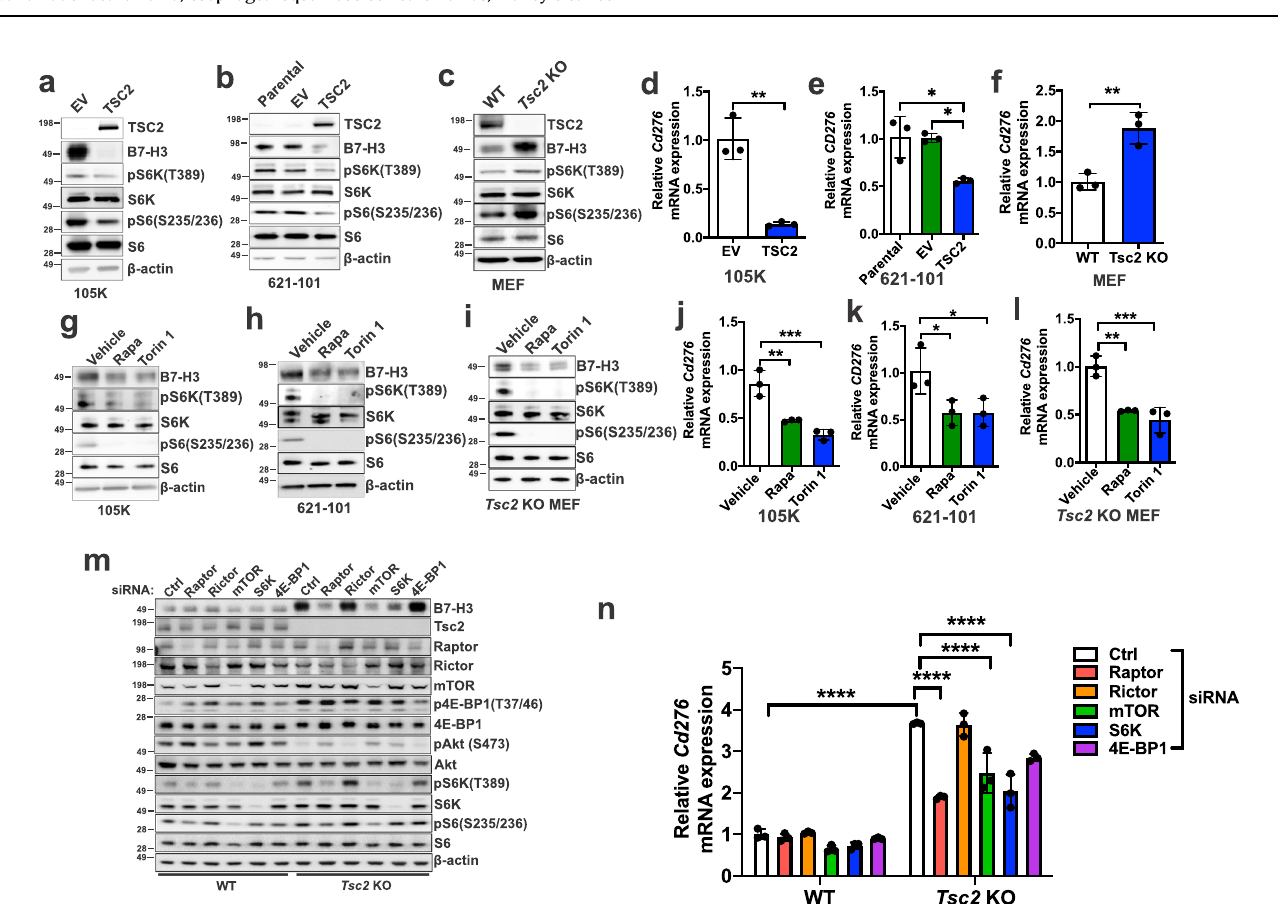
Fig. 1 | Elevated mTORC1 activity and B7-H3/ CD276 expression are associated with poorer clinical outcomes and immunosuppressive phenotypes. Kaplan- Meierplotofoverallpatientsurvivalstrati fi edbyhigh( n =2076)andlow( n =2185) CD276 expression ( a ), high ( n =2001) and low ( n =2268) mTORC1 score ( b ), and high CD276 expression plus high mTORC1 score ( n =1296) and low CD276 expres- sion plus low mTORC1 score ( n =1160) ( c ). Log-rank test. Forest plot of hazard ratios by tumor type and overall (with 95% con fi dence intervals) strati fi ed by high and low CD276 expression ( d ), high and low mTORC1 score ( e ), and high and low CD276 expression plus high and low mTORC1 score ( f ).Hazard ratio greater than 1 (red) indicates an association with worse outcome. COX proportional hazards regression with Efron ’ s approximation. g , h Representative images of strong and weak immunohistochemicalstaining of phospho-S6(Ser240/244) (pS6) and B7-H3 in tumor tissue microarrays, which include 12 cancer types: meningothelial meningioma, breast in fi ltrating ductal adenocarcinoma, colon adenocarcinoma, stomach adenocarcinoma, prostate adenocarcinoma, uterus adenocarcinoma, ovarian adenocarcinoma, esophageal squamous cell carcinomas, kidney clear cell